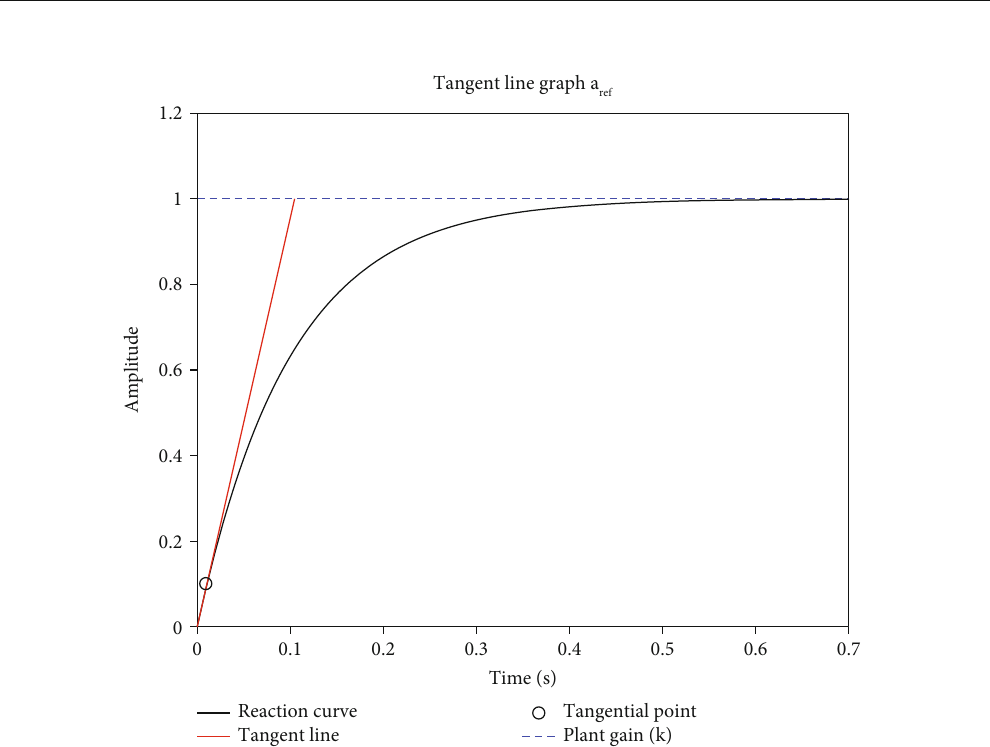
Figure 3: Reaction curve or a